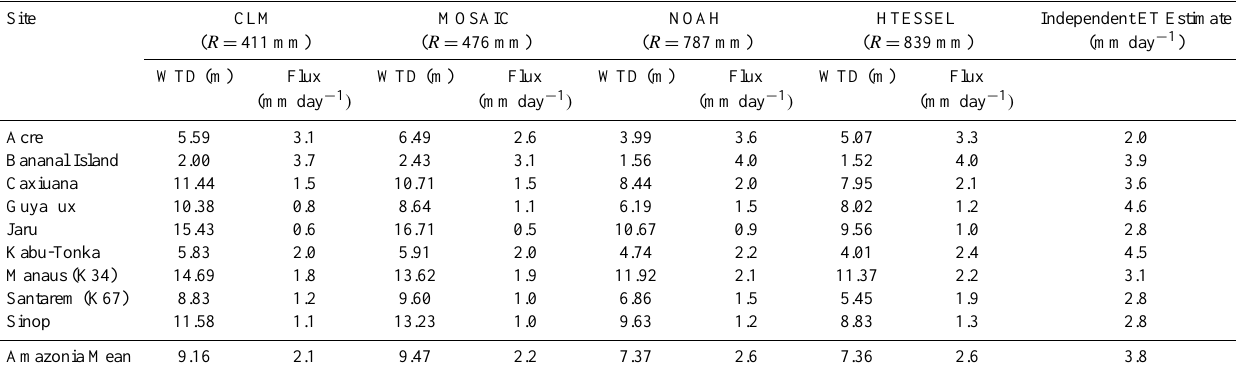
Table 4. WTD and capillary flux (mm day − 1 ) over the flux-tower footprint ( ∼ 2km) from four simulations at nine sites with independent ET estimates and the mean over the Amazonia.